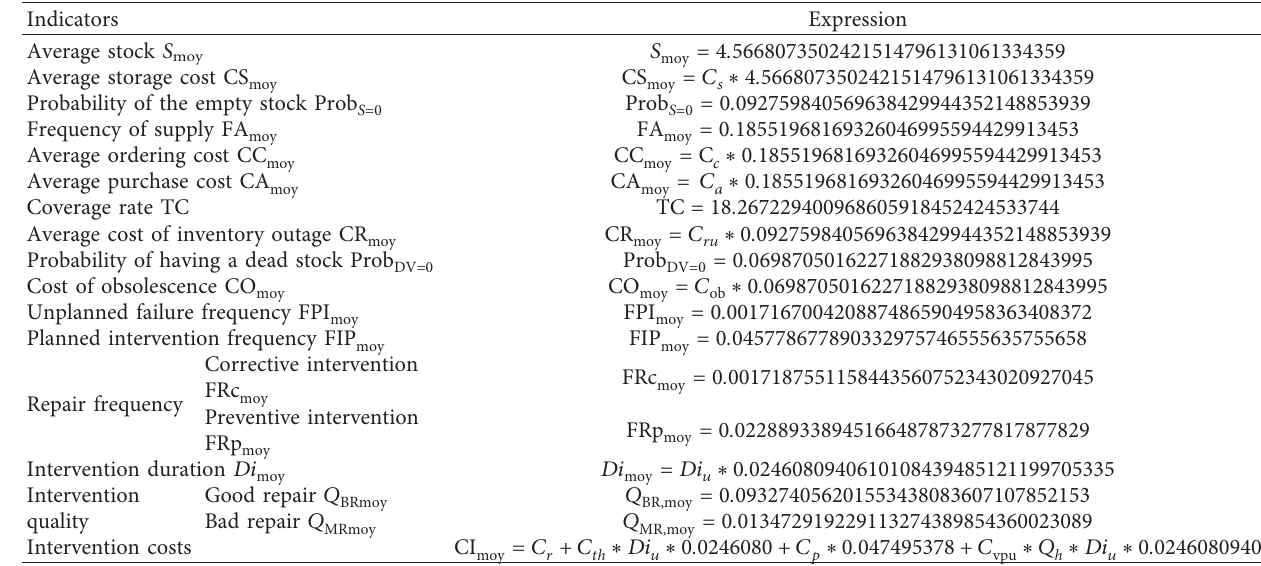
Table 7: Indicators: case